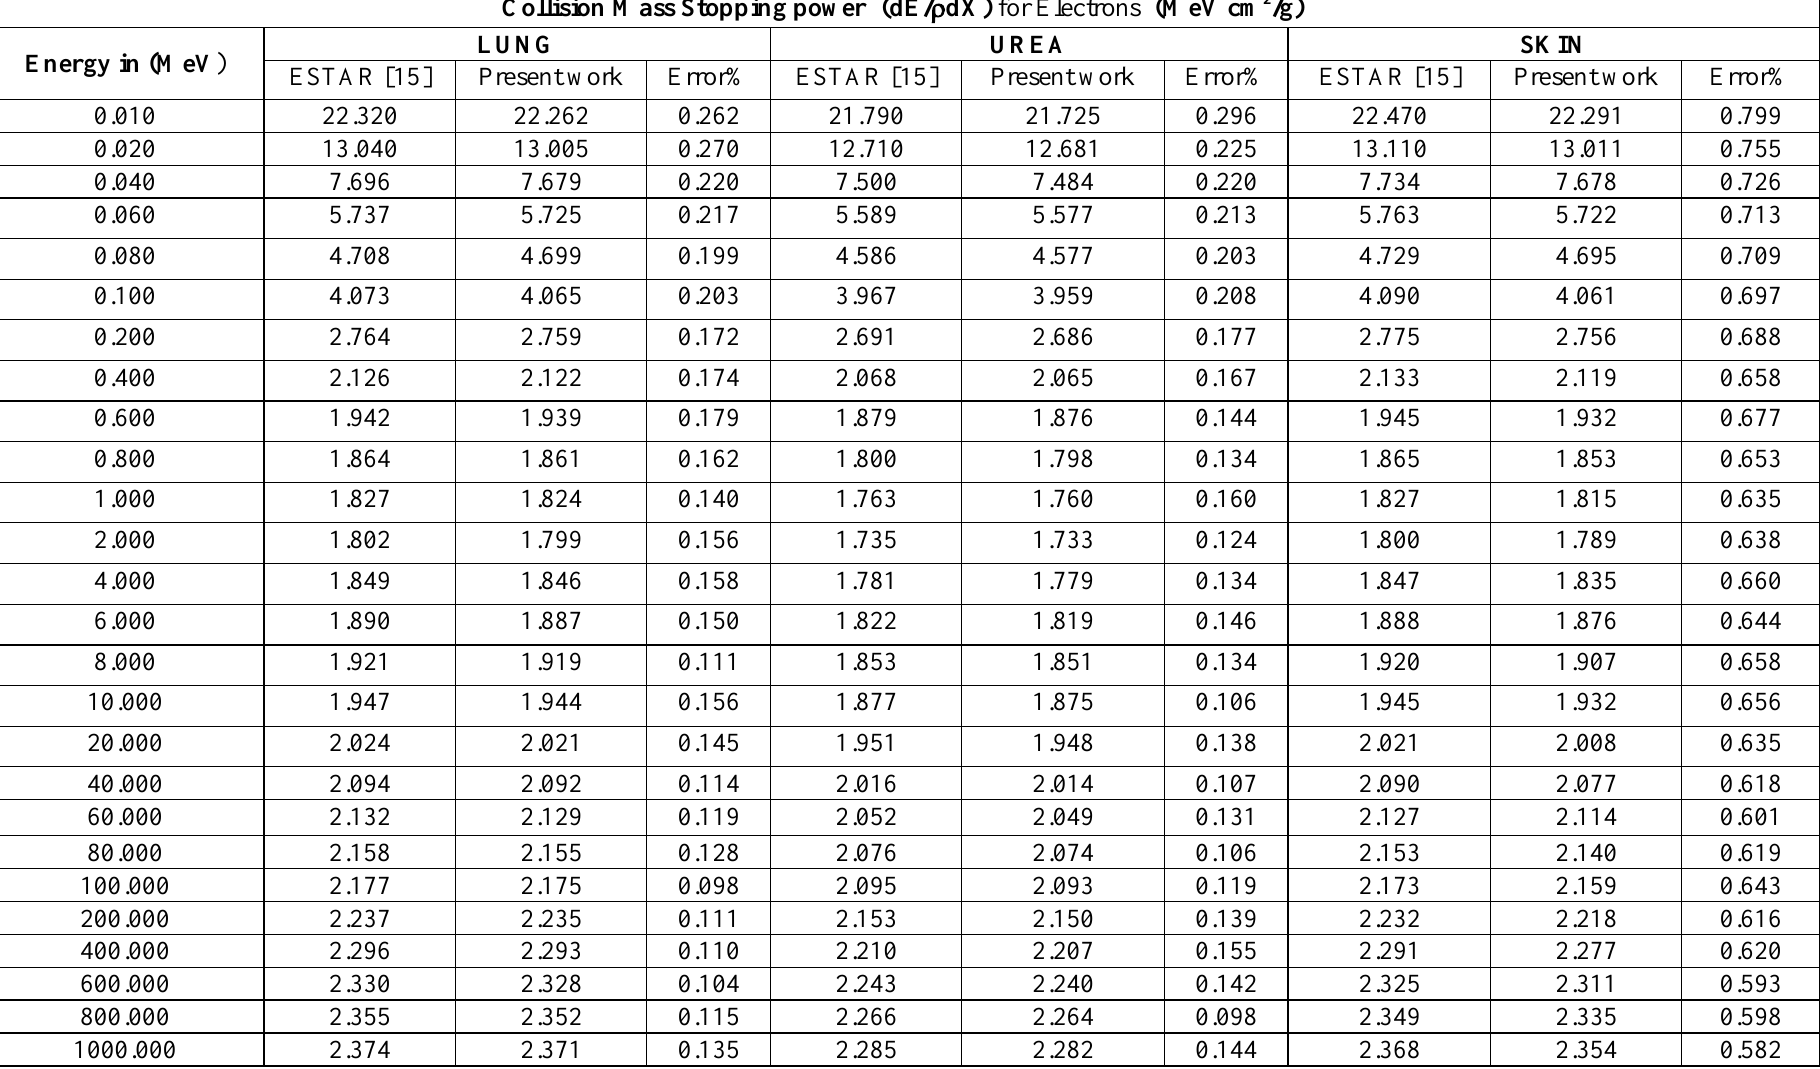
Table 1: Comparison of the present results of the collision mass stopping power for electrons in Lung, Urea and Skin with the standard published data in the energy range (0.01-1000